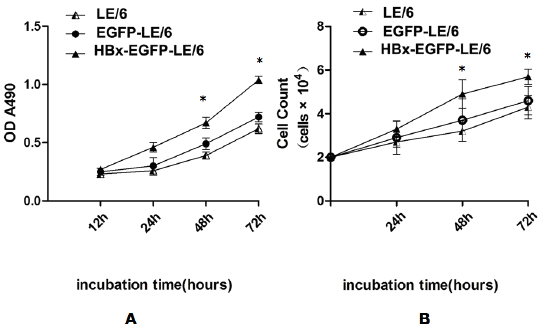
Figure 2. Cells were uniformly seeded in each well of 96-well plates and grown in DMEM supplemented with 10% FBS. After 24 h, the media was removed and replaced with fresh media. After incubation for an additional 12, 24, 48, and 72 h, cell proliferation was assessed by MTT ( A ) and cell count ( B ) assays. Results from both assays showed that HBx expression led to a significant increase in oval cell proliferation compared with controls at the 48 and 72 h time-points. An asterisk * indicates p < 0.05 vs. LE/6 and EGFP-LE/6 controls. The data shown represent the mean ± standard deviation (SD) of three independent experiments.